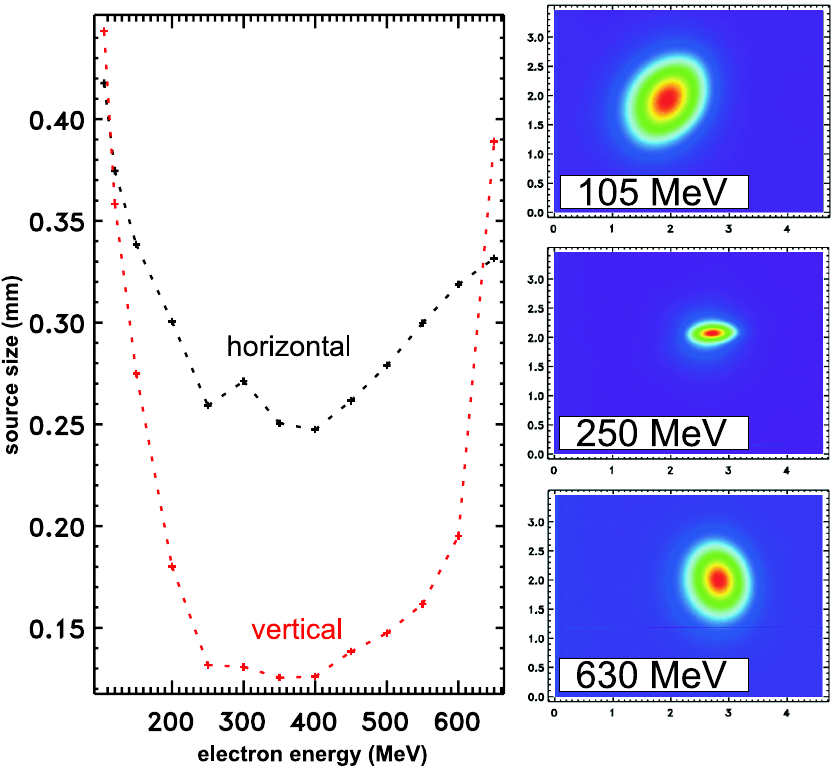
FIG. 15. (Color) Source size ( 1 (cid:1) ) at 4 mA electron beam current determined from the optical image of the electron beam. At low electron beam energies, the beam size is enlarged due to trapped ions. At 630 MeV the vertical size increased mainly because of large coupling.